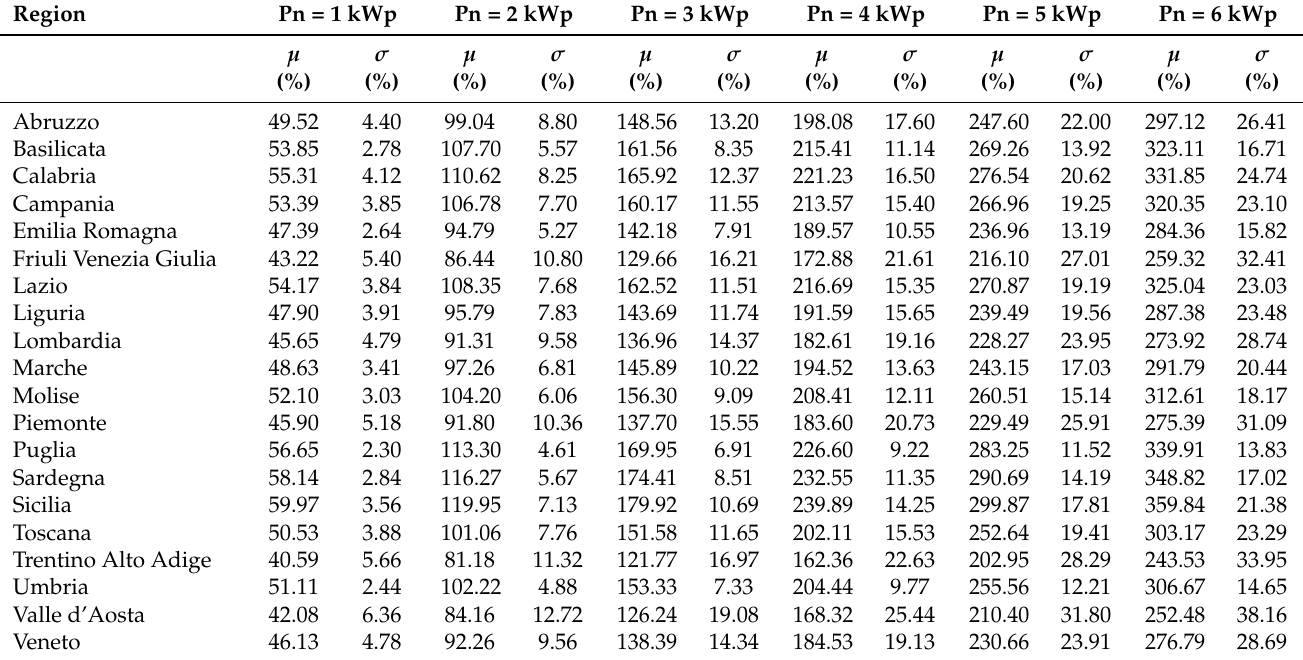
Table 3. CO 2 saving for E L = 2700 kWh without battery.